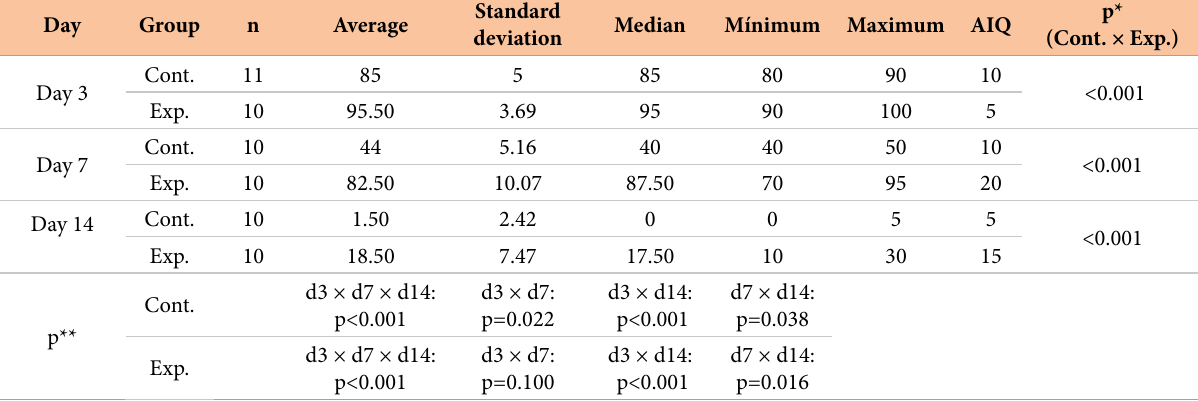
Table 5 - Average percentage of collagen III found in the three times, studied identified by